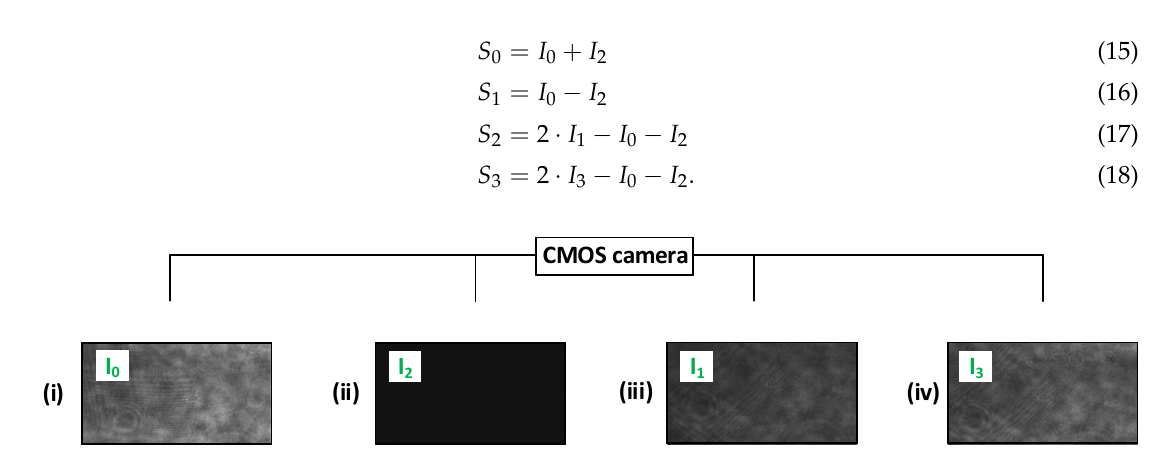
Figure 3. Measurement procedure to obtain the intensities for the calculation of the Stokes parameters S 0 , S 1 , S 2 , and S 3 . ( i ) Measurement 1: Record of the intensity I 0 ; PO: 0 ◦ ; ( ii ) Measurement 2: Record of the intensity I 2 ; PO: 90 ◦ ; ( iii ) Measurement 3: Record of the intensity I 1 ; PO: 45 ◦ ; ( iv ) Measurement 4: Record of the intensity I 3 ; PO: 45 ◦ and QWP: 45 ◦ (Images from the measurement of a surface with the RMS roughness S q = 31nm at a wavelength of λ Ar + =